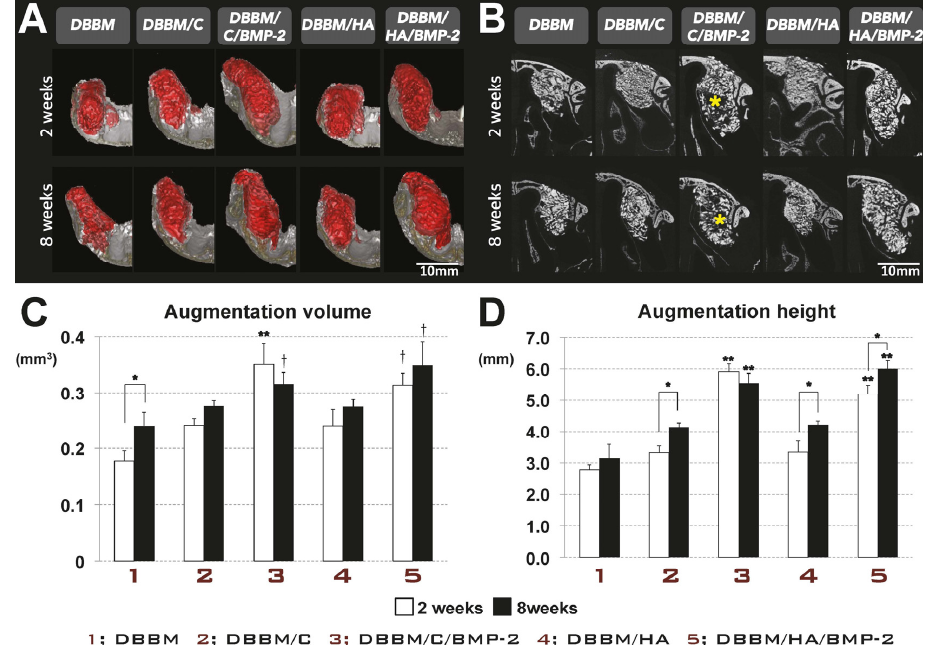
Figure 2. Radiographic analysis: micro ‐ computed tomography in the rabbit sinus ‐ augmentation model. ( A ) Three ‐ dimensionally reconstructed views of the augmented sites at two weeks and eight weeks (scale bar = 10 mm); ( B ) Representative coronal cross ‐ sectional images at two weeks and eight weeks (scale bar = 10 mm). Coronally sectioned views of the DBBM/C/BMP ‐ 2 group specifically exhibited radiolucent zones (* yellow) within the augmented area. These radiographic voids also decreased between weeks 2 and 8. Radiographically measured results demonstrated that the two experimental groups that received rhBMP ‐ 2 exhibited increased augmentation volume (AV; C ) and augmentation height (AH; D ) compared to the other three groups in which rhBMP ‐ 2 was not applied (** p < 0.05). The AV was significantly larger in both rhBMP ‐ 2 ‐ applied groups than in the DBBM group († p < 0.05). AH was measured linearly on the cross ‐ sectional images. Regardless of the healing period, AH was significantly greater in the rhBMP ‐ 2 ‐ applied groups than in the other three groups (** p < 0.05). AH increased between weeks 2 and 8 in all groups except the DBBM/C/BMP ‐ 2 group (* p < 0.05). DBBM, deproteinized bovine bone mineral; C, absorbable collagen sponge; BMP ‐ 2, bone morphogenetic protein-2; HA, hydroxyapatite-coated collagen.